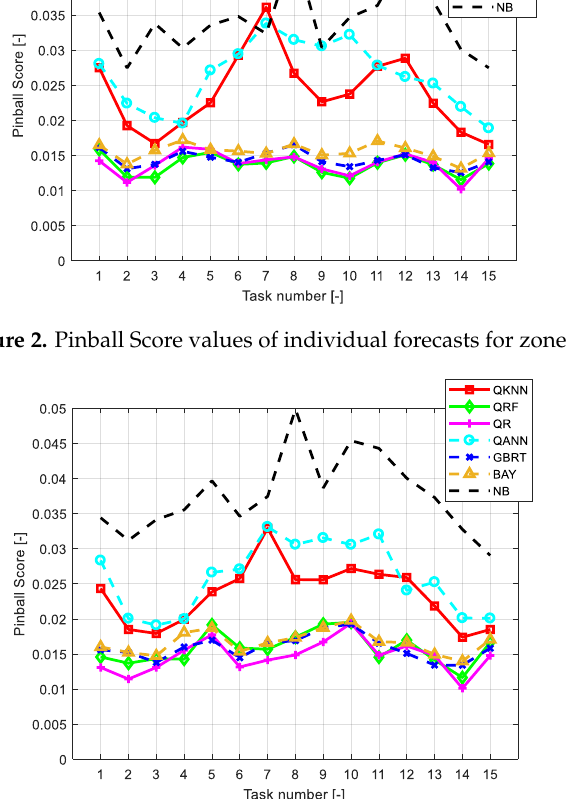
Figure 3. Pinball Score values of individual forecasts for zone 2.